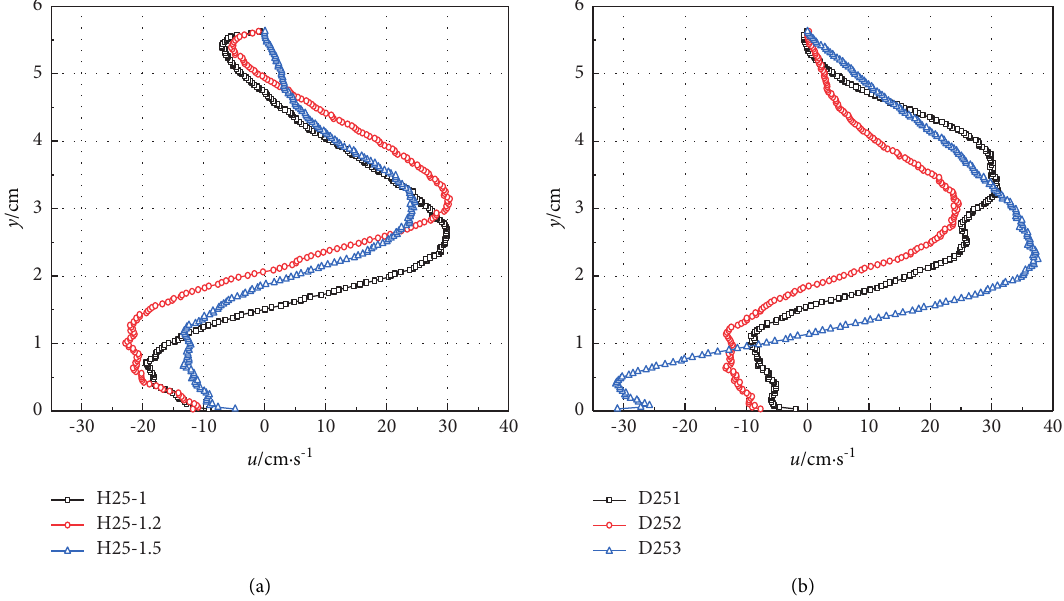
Figure 4: The vertical distribution of the time-averaged longitudinal velocity in different working conditions ( x � 2cm).